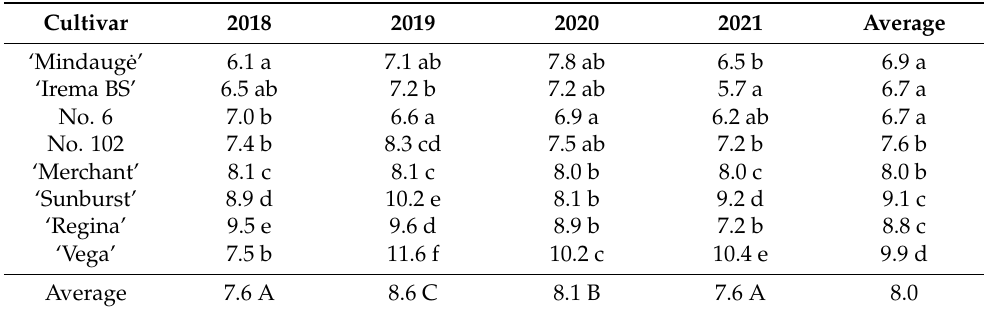
Table 5. The average sweet cherry fruit weight (g). Values marked with different small letters are statistically different within the columns and with the capitals—in the row ( p ≤